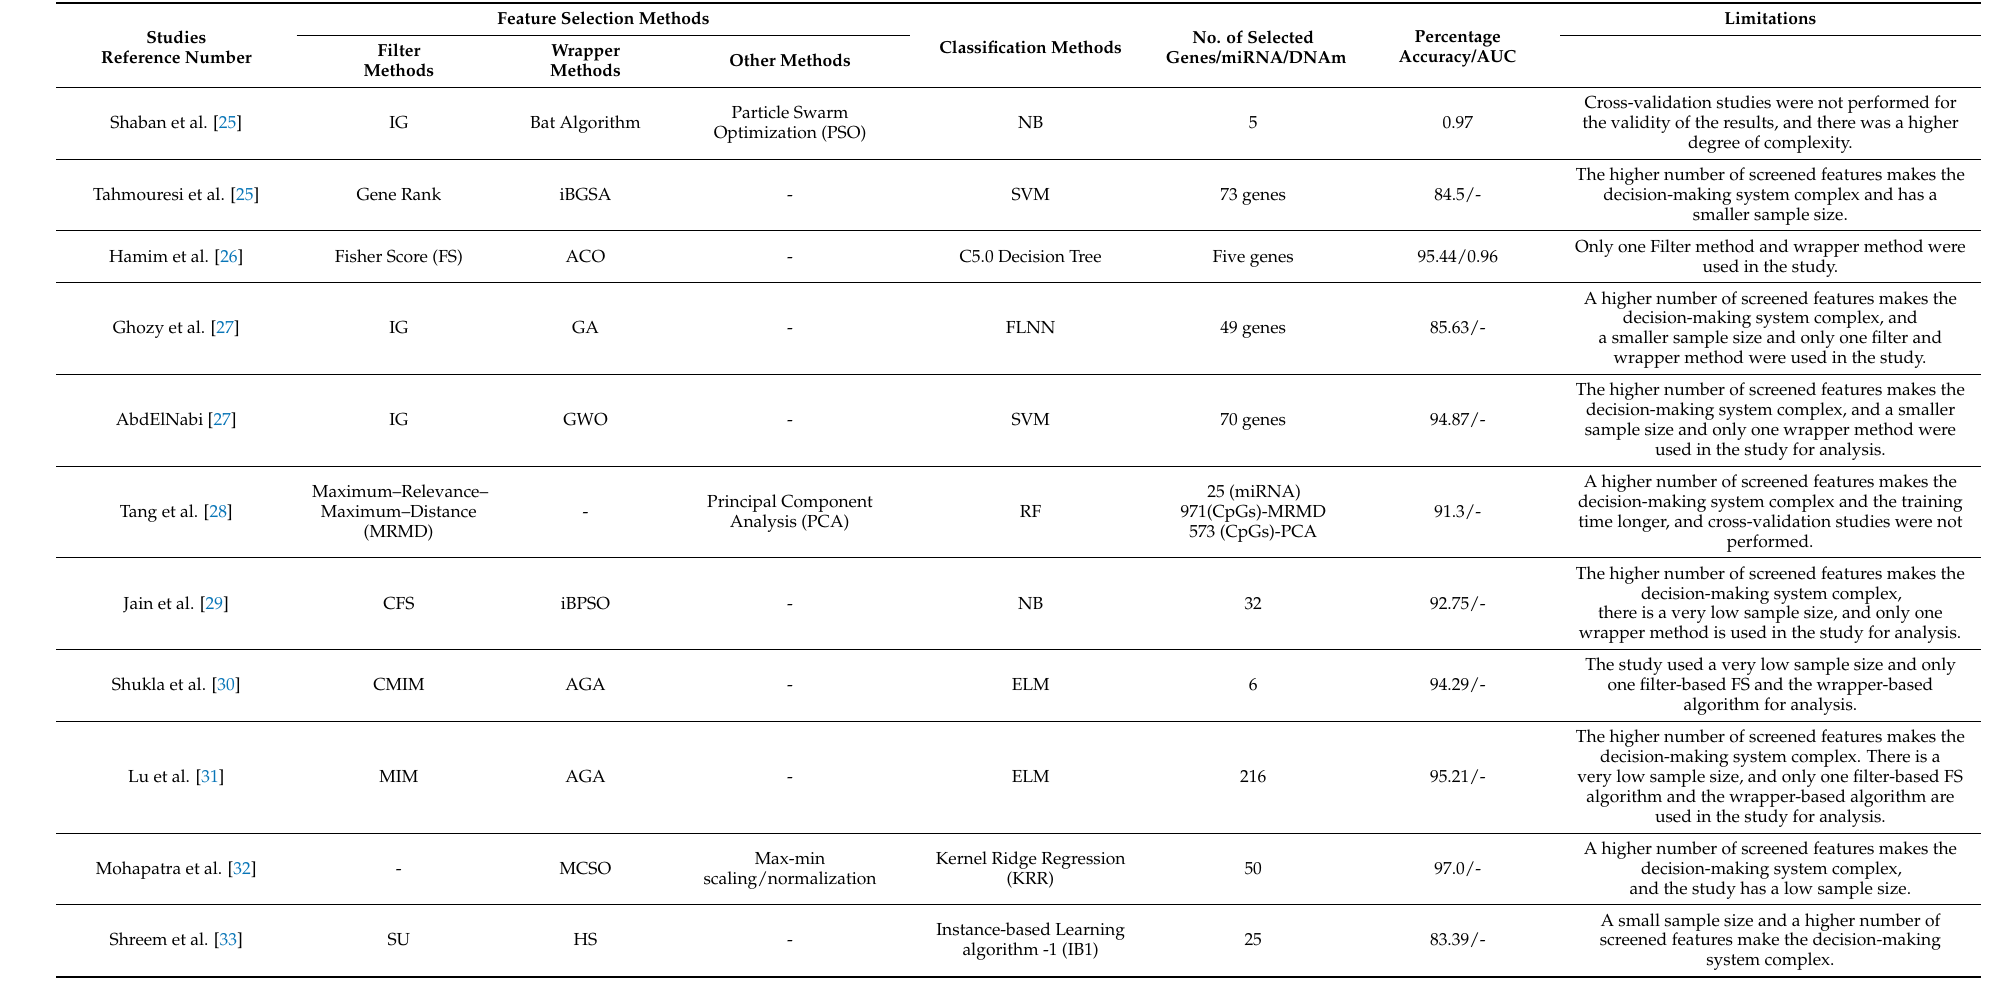
Table 1. Comparison of various FS algorithms for selecting the most informative features to classify microarray BC data. The symbol “-“means the unavailability of